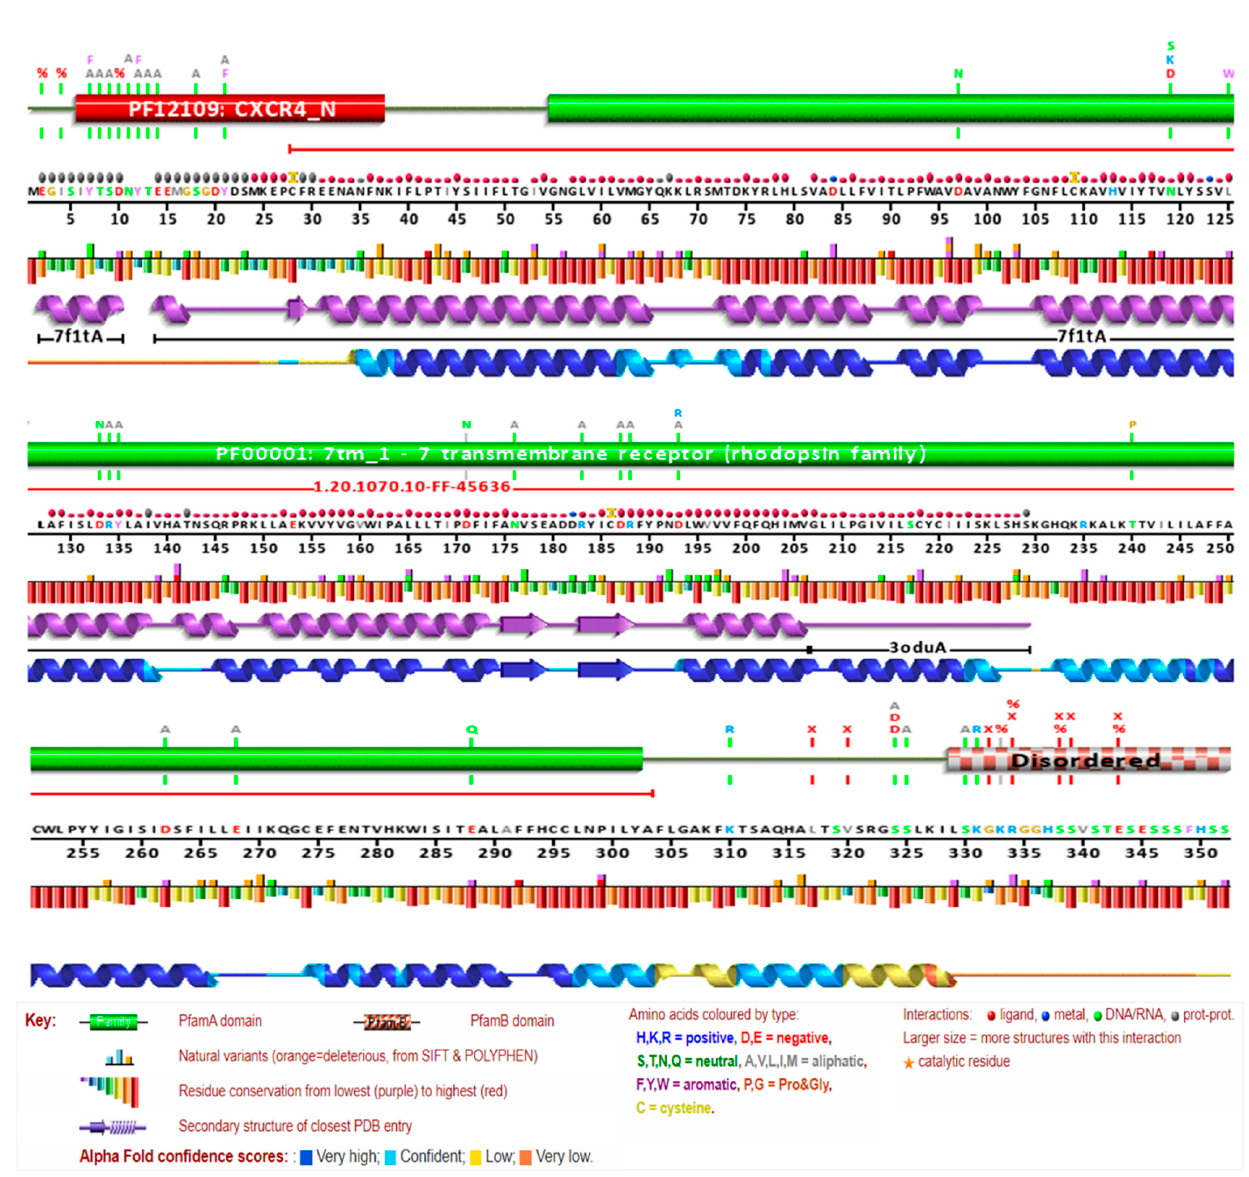
Figure 4. Prediction of the secondary structure of CXCR4 protein. Conserved residues are represented by letters, and helices in the tertiary structure are shown in different colors. Red bar points out a protein’s three main structural elements: a β -sheet, a coil, and an α helix. The human CXCR4 protein is depicted in the upper panel.